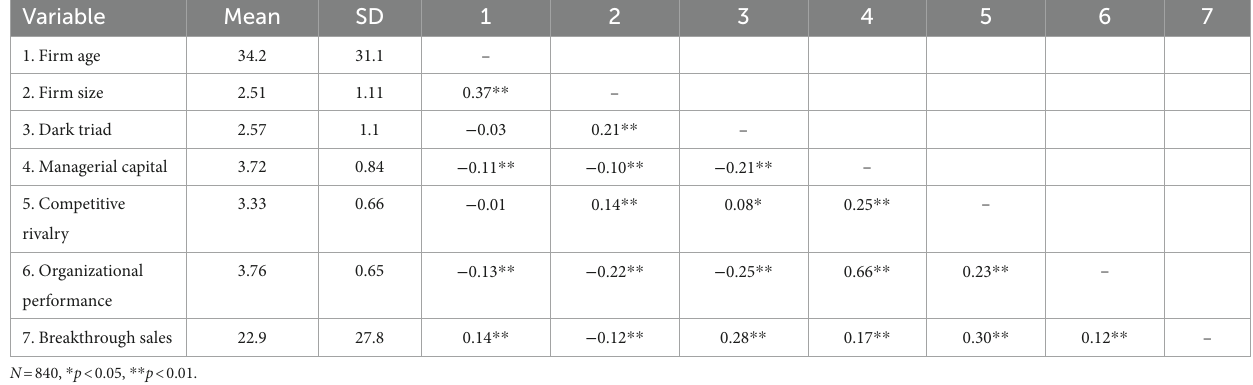
TABLE 2 Correlations and descriptive statistics of study variables.